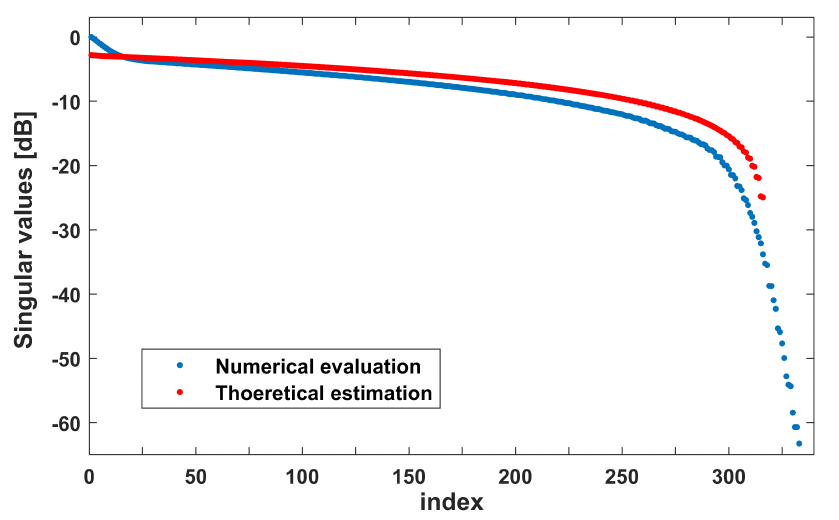
Figure 12. Singular values of A numerically computed, and their analytical estimation for the case a = 20 λ , z 1 = 5 λ , z 2 = 7.5 λ , X 1 = 37.03 λ ( η ( X 1 , z 1 ) = 0.99 ) , X 2 = 50.97 λ ( η ( X 2 , z 2 ) = 0.99 )